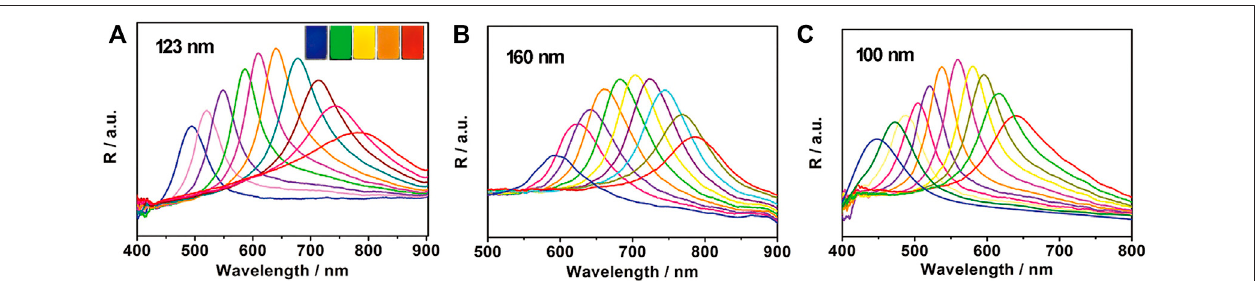
FIGURE 2 | Re fl ection spectra of Fe 3 O 4 @PAA colloidal aqueous solutions with different particle sizes. (A) 123 nm; (B) 160 nm; and (B) 100 nm, under different MFs achieved by changing the sample-magnet distance from 7 to 3 cm for (A) , from 8 to 3 cm for (B) , and from 6 to 1 cm for (C) with a step of 0.5 cm. Reprinted with permission from Yang et al. (2016). Copyright 2016 © Royal Society of Chemistry.